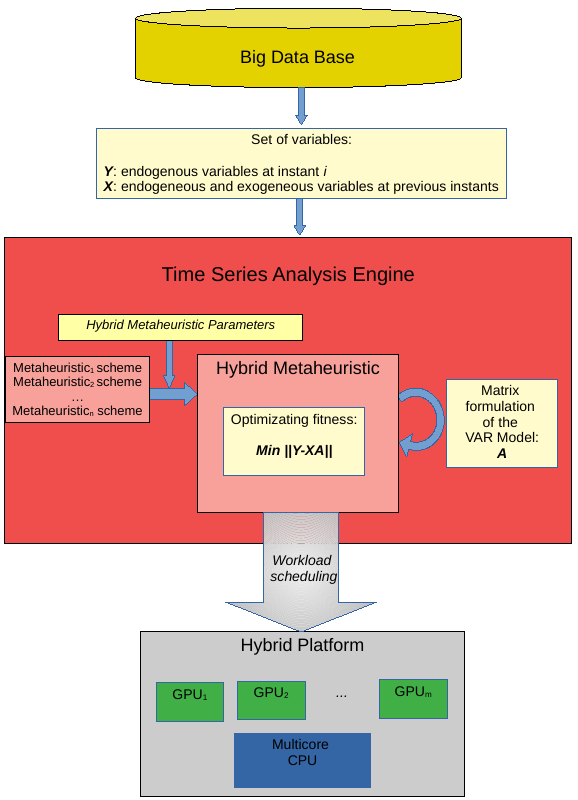
Figure 1. Operation diagram of the time series analysis